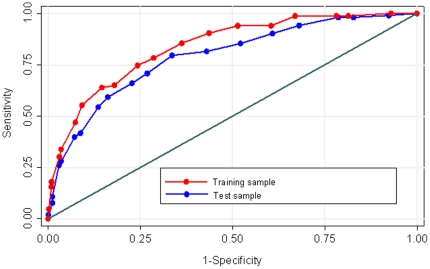
Receiver operating characteristics (ROC) of the risk score in the first cohort and in the test cohort.